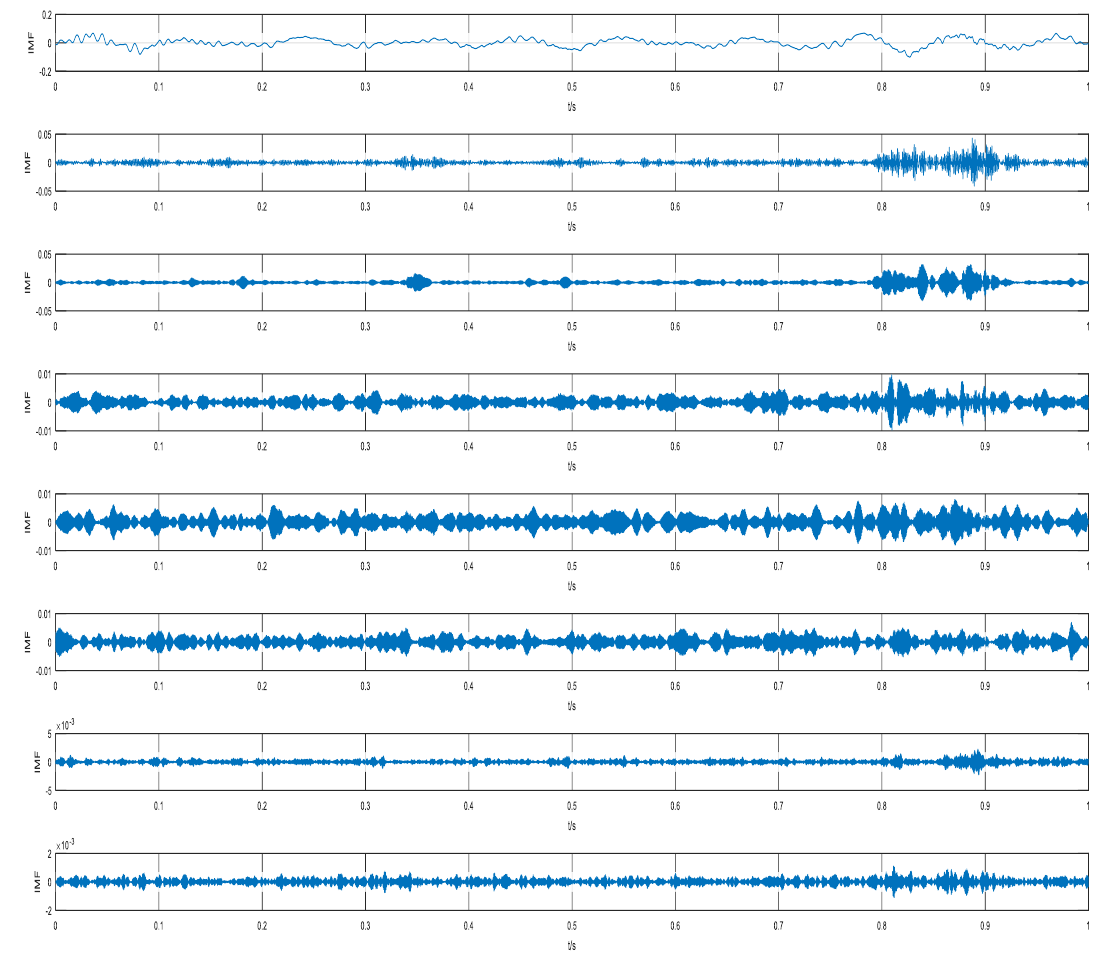
Figure 13. An example of results by VMD under normal conditions.